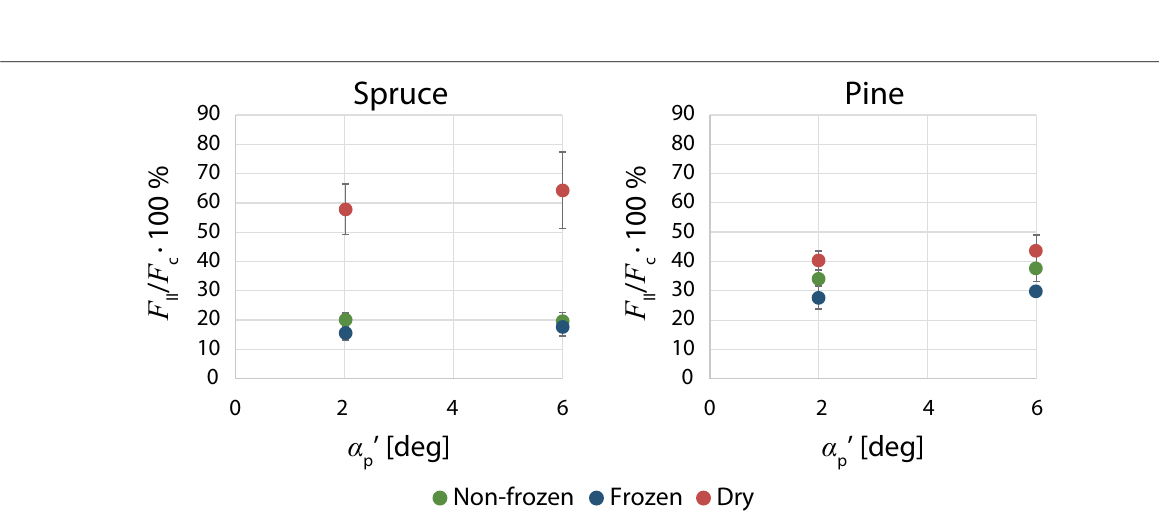
Fig. 13 The Zone II force contribution to the cutting force for with varying minor cutting edge angles ( α ′ p